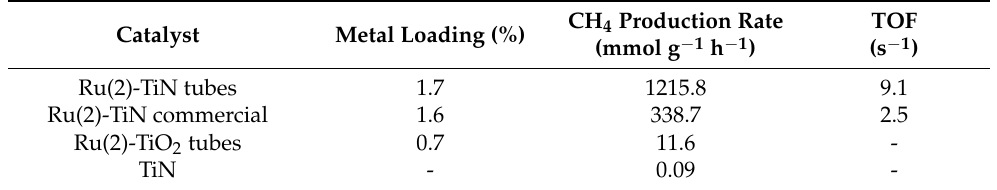
Figure 5. ( a ) Temperature (black line) and pressure (red line) profiles of Ru(2)-TiN photocatalyst under photo-thermal CO 2 methanation during first (squares), second (circles), third (diamonds) and fourth catalytic cycle (hexagons). ( b ) CO 2 conversion values upon four consecutive catalytic cycles. Measurements were repeated 3 times. Table 1. Metal loading, CH 4 production rate and turnover frequency (TOF) of different photocatalysts used in this work.